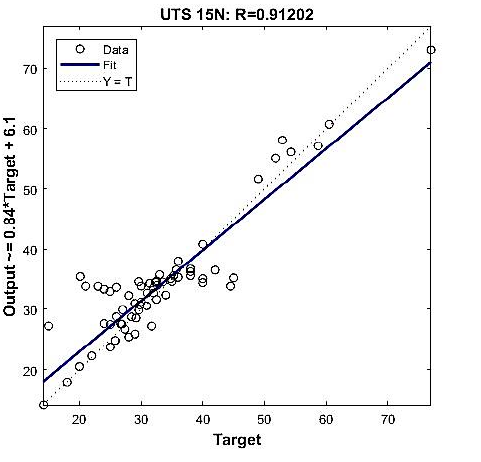
Figure 2. Process flowchart of the computational arrangement.